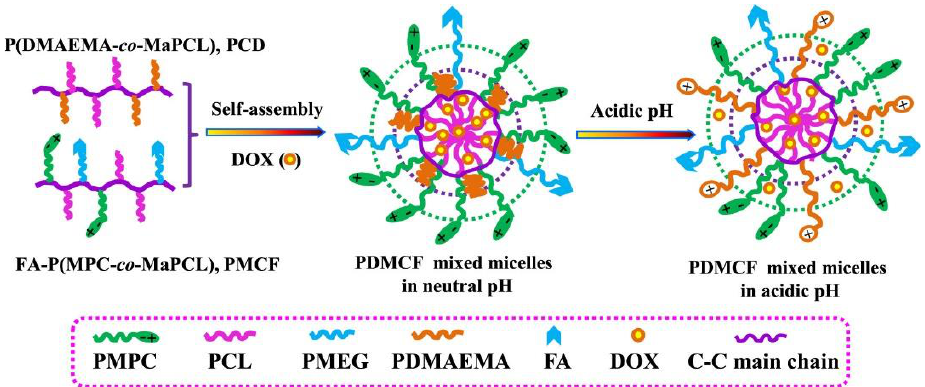
Figure 2. Schematic Illustration of the Formation of the Mixed Micelles and Their pH-Dependent DOX Release (Adapted and reused from [61], 2022, American Chemical Society).